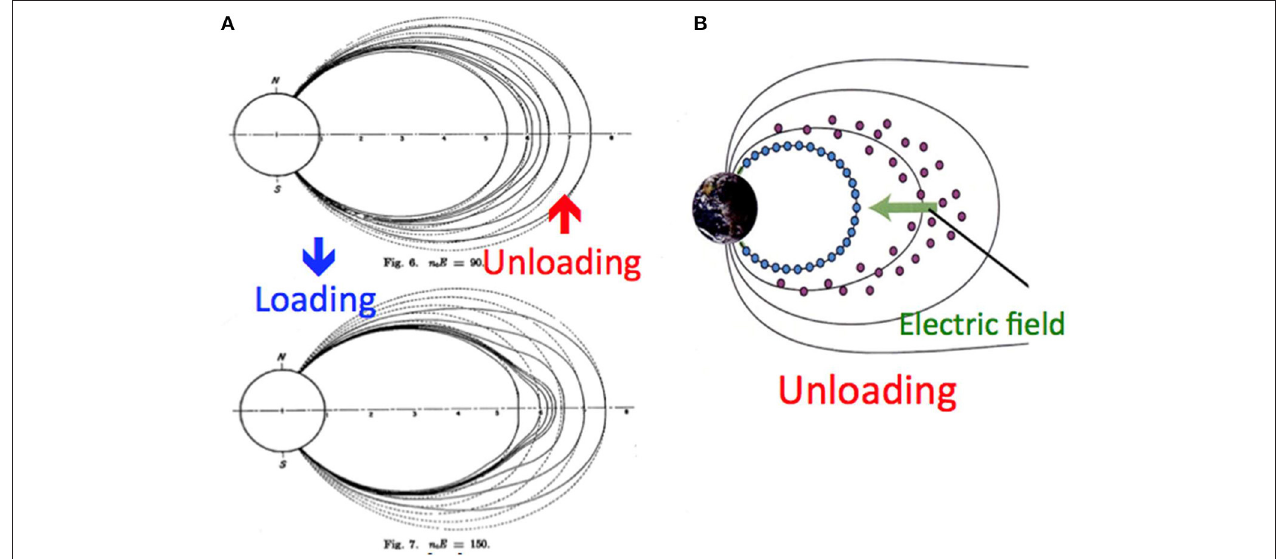
FIGURE 11 | (A) when the dynamo power is increased (in the case of the average substorm), the current loaded around 6 Re ( Figure 6B ) is increased. As a result, the magnetosphere is inflated as shown. The magnetic configuration changes from the above (pre-substrom condition to below (just before the expansion phase onset). At the expansion onset, the magnetosphere is deflated and return back to the pre-substorm condition. (B) during this returning back to the pre-substorm condition, electrons tend to follow the contracting field lines, not proton, generating an earthward electric field.